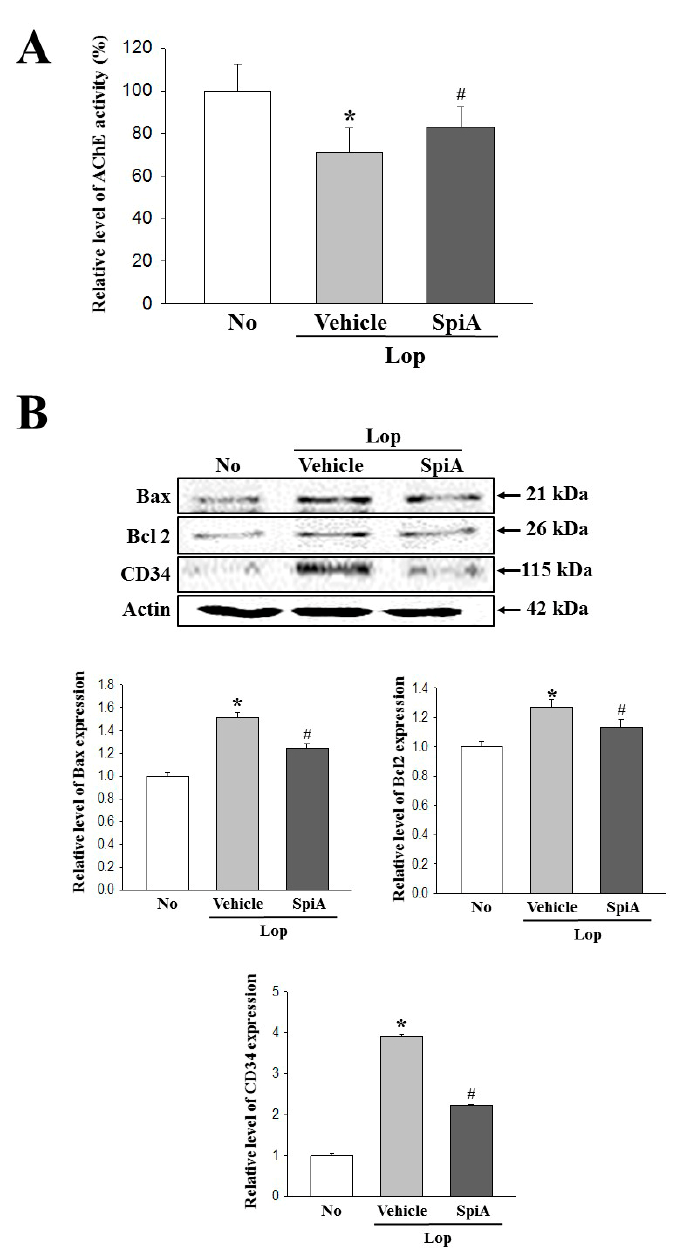
Figure 4. Measurement of AChE activity. ( A ) After homogenization of colon tissue, AChE activity was measured using an Acetylcholinesterase Assay Kit that could detect as little as 0.01 mU AChE in a 100 µ L assay volume (0.1 mU/mL). Five to six mice per group were used in preparation of tissue lysate and enzyme activity was assayed in duplicate in each test. ( B ) The expression of Bax, Bcl-2 and CD34 protein representing apoptotic phenomena were measured by Western blot analysis using horseradish peroxidase (HRP)-labeled anti-rabbit IgG antibody. Five-to-six mice per group were used in preparation of total lysate and specific protein level was assayed in duplicate in each test. Data are reported as the mean ± SD. *, p < 0.05 compared to the untreated group. # , p < 0.05 compared to the Lop + Vehicle treated group. No, Untreated group; Lop, Loperamide; SpiA, Spicatoside A; AChE, Acetylcholinesterase, HRP; Horseradish peroxidase.